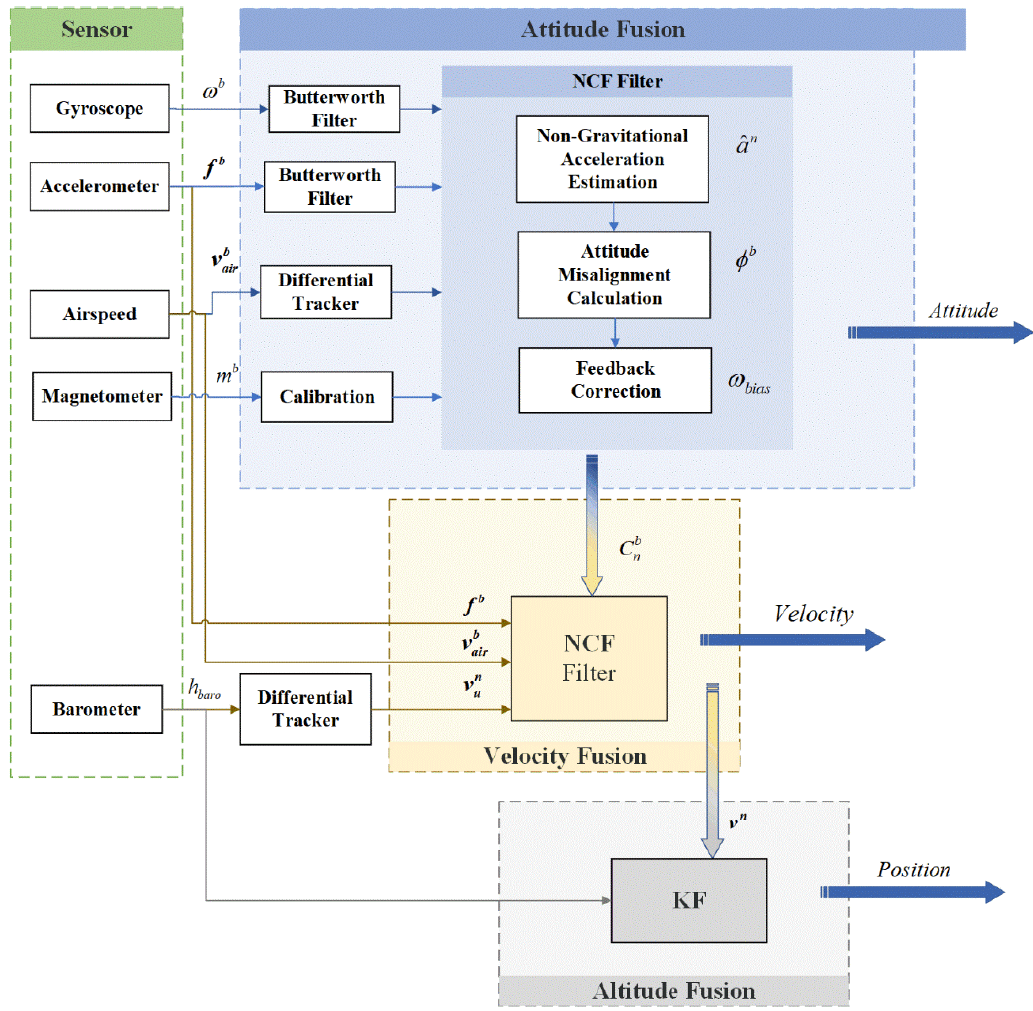
Figure 1. The framework of the multisensor fusing algorithm in this paper is divided into four parts. The green area shows the sensors we used in this study; the original sensor’s data will first be preprocessed, including using the Butterworth low-pass filter to reduce the high-frequency noise of the gyroscope and accelerometer, and using a differential tracker (DT) for the airspeed and barometer. The blue part is the attitude fusion frame, mainly divided into three parts: the main filter, the gravitational acceleration estimation described in Section 2.1, and the attitude misalignment angle calculation and the error feedback compensation are described in Section 2.2. Meanwhile, the yellow area presents the velocity fusion frame, and in Section 2.3, the filter which combines the barometer and airspeed is mainly described. The gray area represents the altitude fusion frame by the Kalman filter, which is established in Section 2.4.